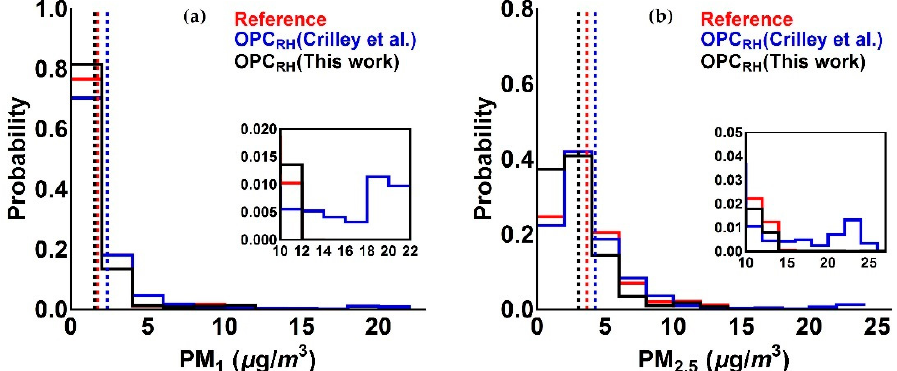
Figure 7. Probability distribution plot of Alphasense OPC-N2 measurement, after the application of the correction factor [16] and the correction algorithm (this work), in comparison with reference data for ( a ) PM 1 and ( b ) PM 2.5 . The dashed lines represent the mean of PM values in each case. The inserts figures show PM probabilities at higher values on expanded scales (see text). Table 3. Average PM values for the corrected OPC and reference measurements in Figure 6. Reference